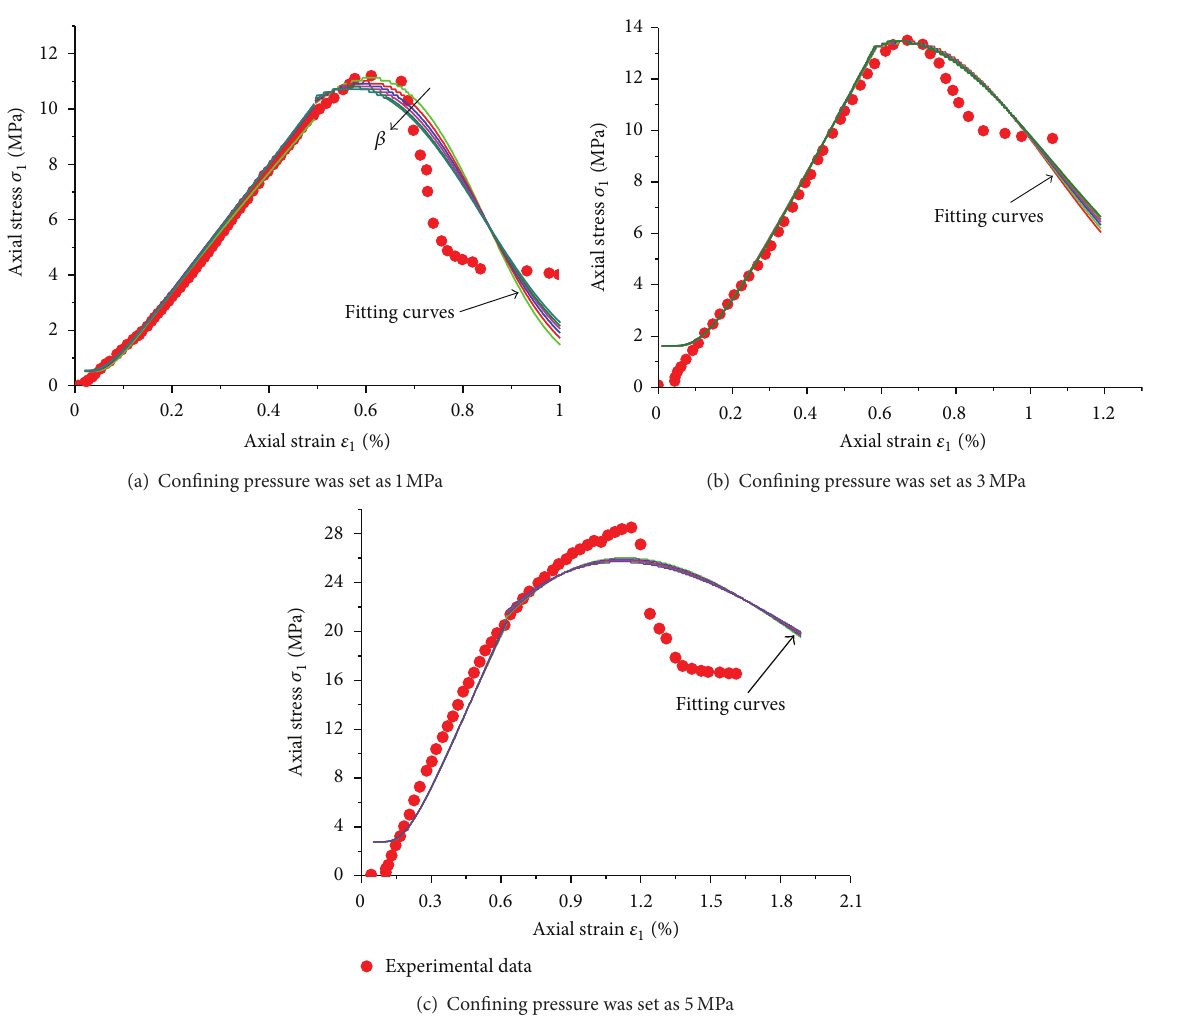
Figure 13: Comparison of fitting curves with experimental data under different confining pressures.